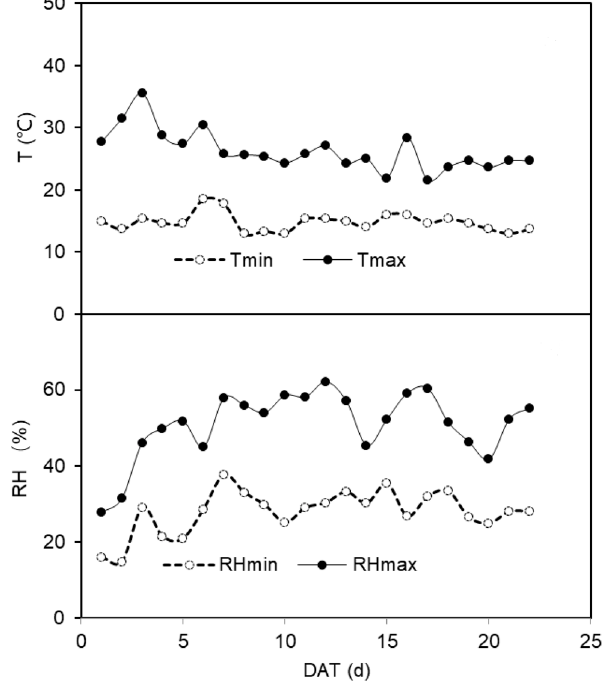
Figure 3. The maximum and minimum daily temperature (T, ◦ C) and the daily maximum and minimum relative humidity (RH, %) in the greenhouse during the treatment period. Tmin and Tmax indicate the minimum and maximum daily temperature, respectively; RH min and RHmax indicate the minimum and maximum daily relative humidity,